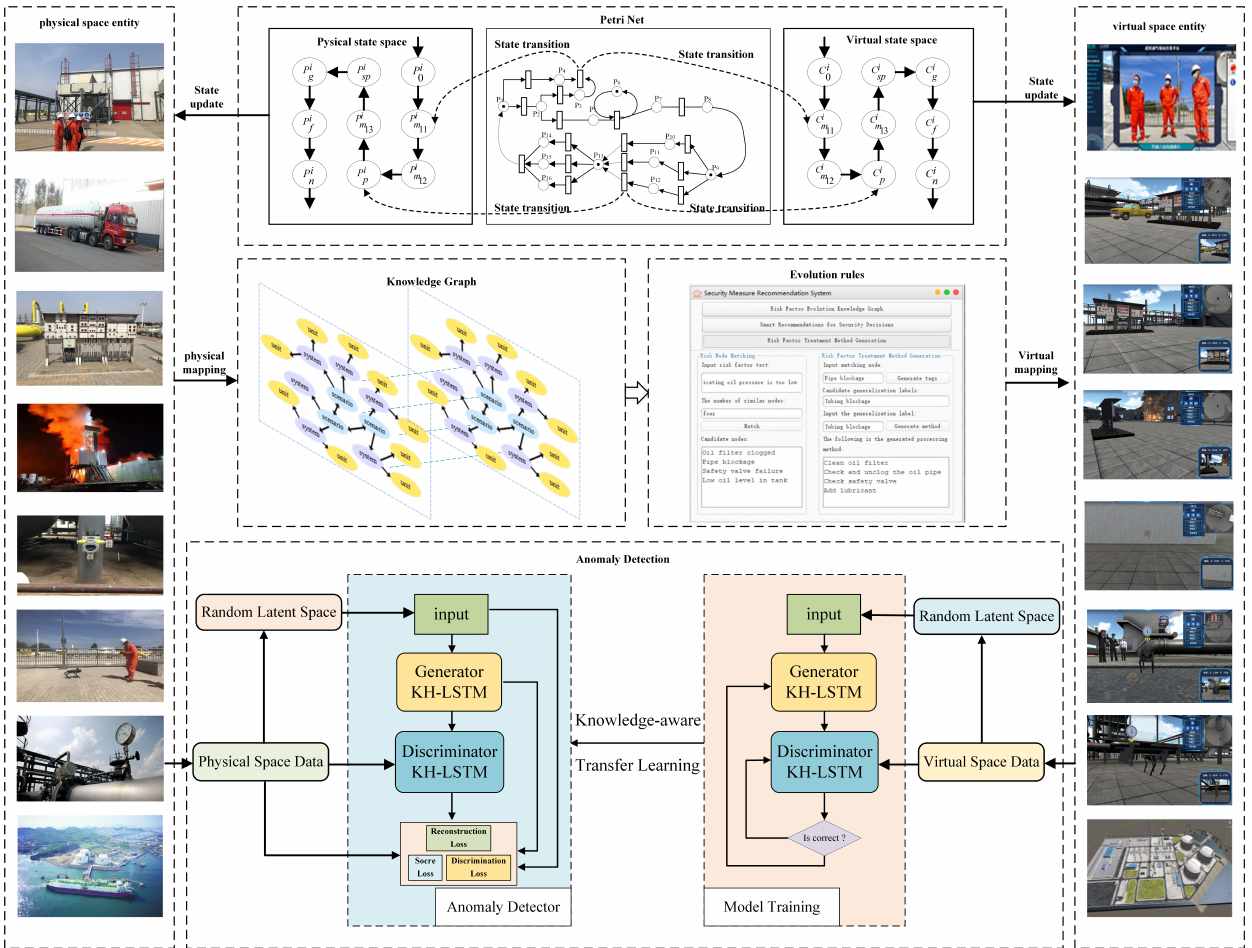
Figure 1. Oil and gas station digital twin